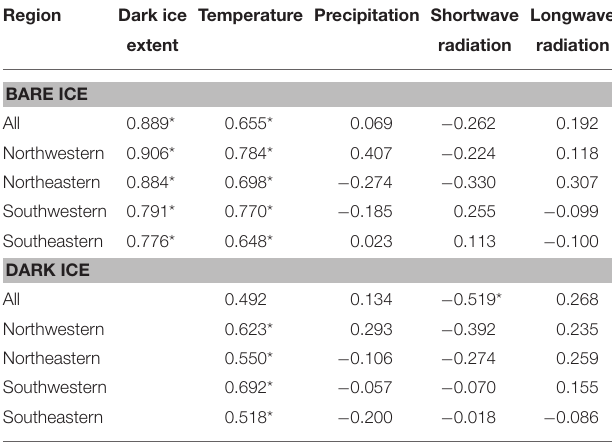
TABLE 1 | Correlation coefficient of dark ice extent, temperature, winter precipitation, shortwave radiation flux, and longwave radiation flux for the extent of bare ice and dark